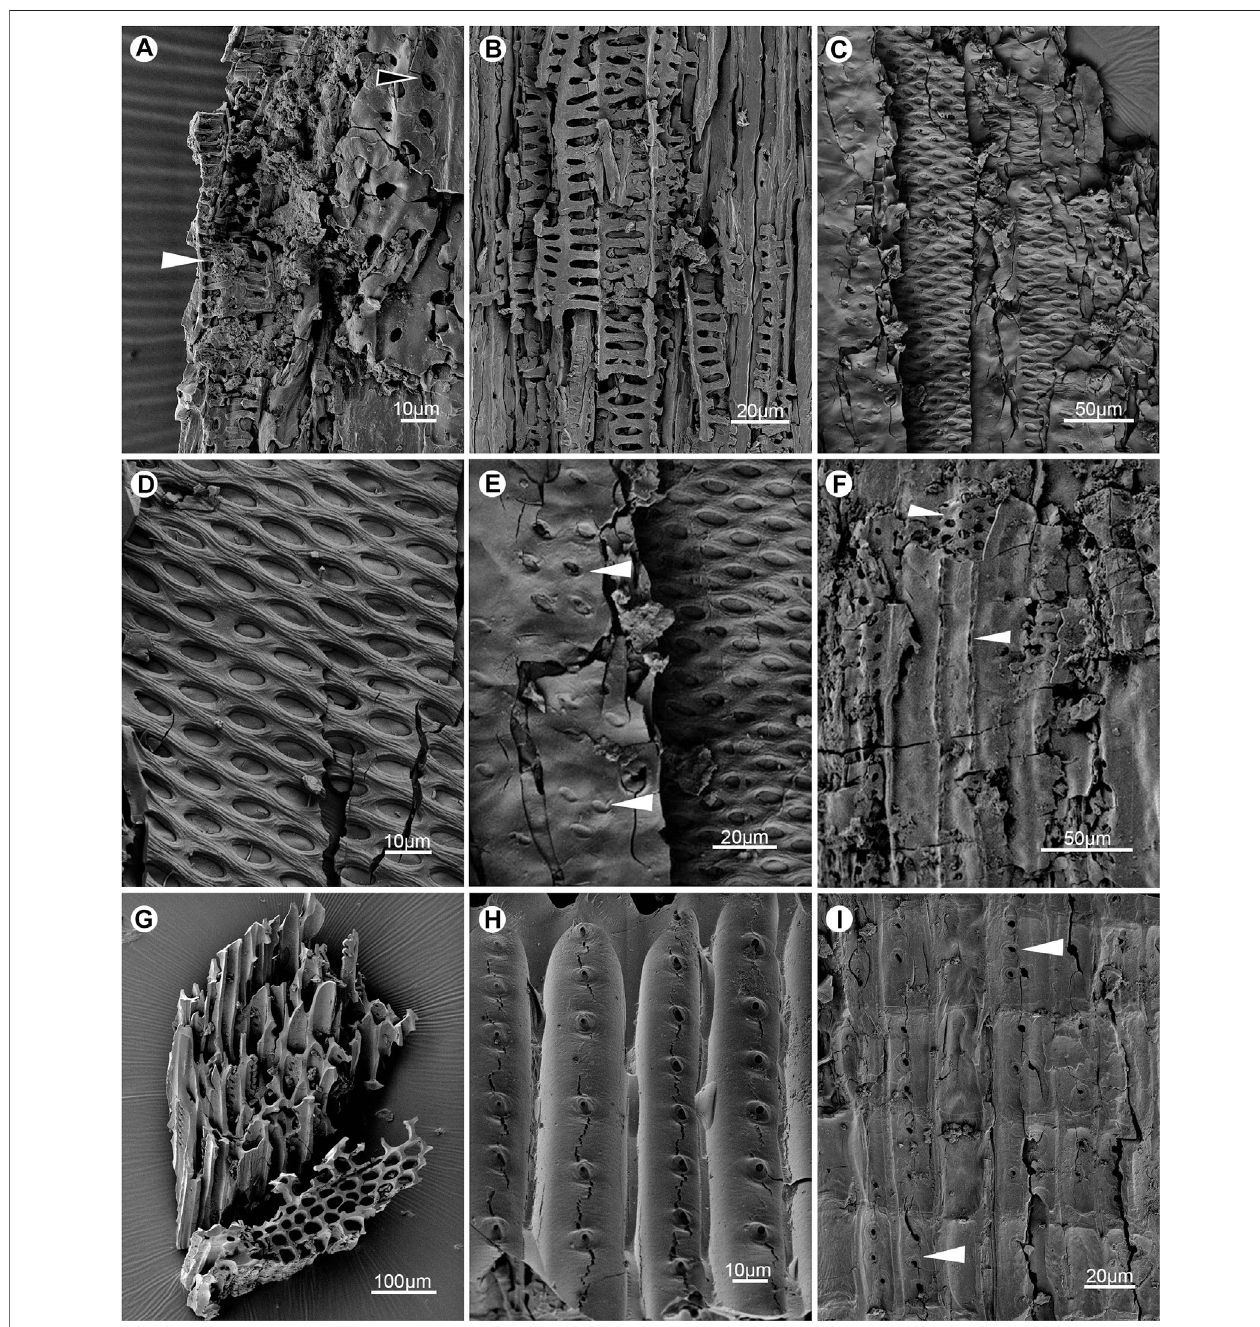
FIGURE 3 | SEM images of charcoal Type 3 (A – F) and Type 4 (G – I) from the Lengqinggou section in Guizhou Province, Southwest China. (A) Primary xylem tracheid with annular wall thickenings (white arrow) and secondary xylem tracheid with multiseriate pits (black arrow). (B) Primary xylem tracheids exhibit scalariform thickenings. (C) Imageofsecondaryxylemtracheids,showingmultiseriatepitsontheradialwalls. (D) Secondaryxylemtracheidshowsmultiseriate,alternatelyarranged, and transversely elongated radial pits. (E) Higher magni fi cation image of Fig. C, showing 36 pits in cross- fi elds (arrows). (F) Tangential view of tracheids, showing distinctpitcavities(lowerarrow), bend radialwall withborderedpit(upperarrow) and smooth tangential wall. (G) Charcoal oftype 4. (H) Radial view,showinguniseriate, discontiguous pits on the radial tracheid walls. (I) Cross- fi elds with 1 – 4 pits (arrows).